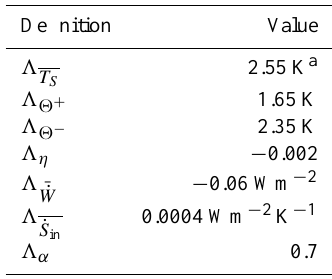
Table 1. Generalized